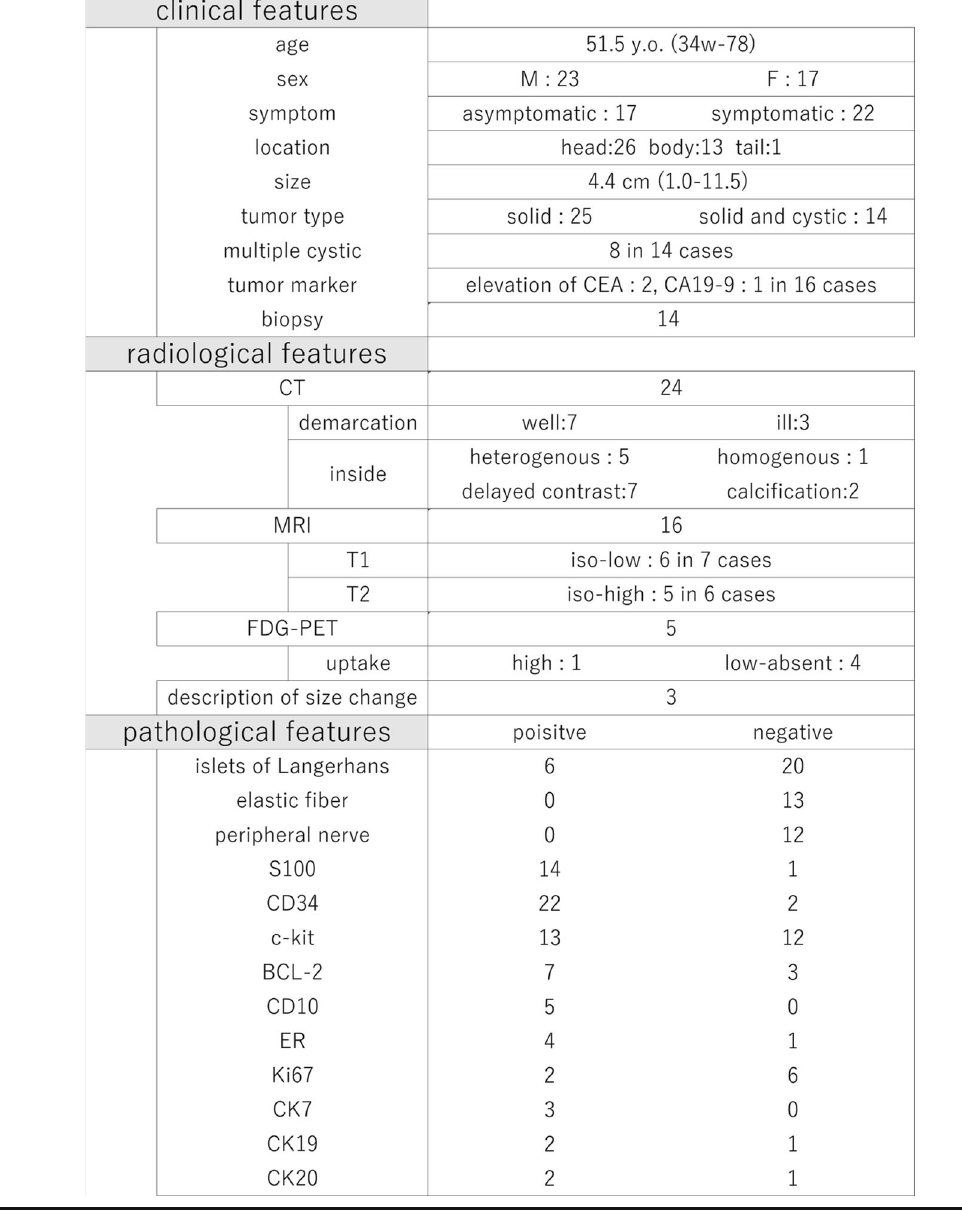
Table 1 Summarized clinical, radiological, and pathological features of reported pancreatic hamartomas in the literature